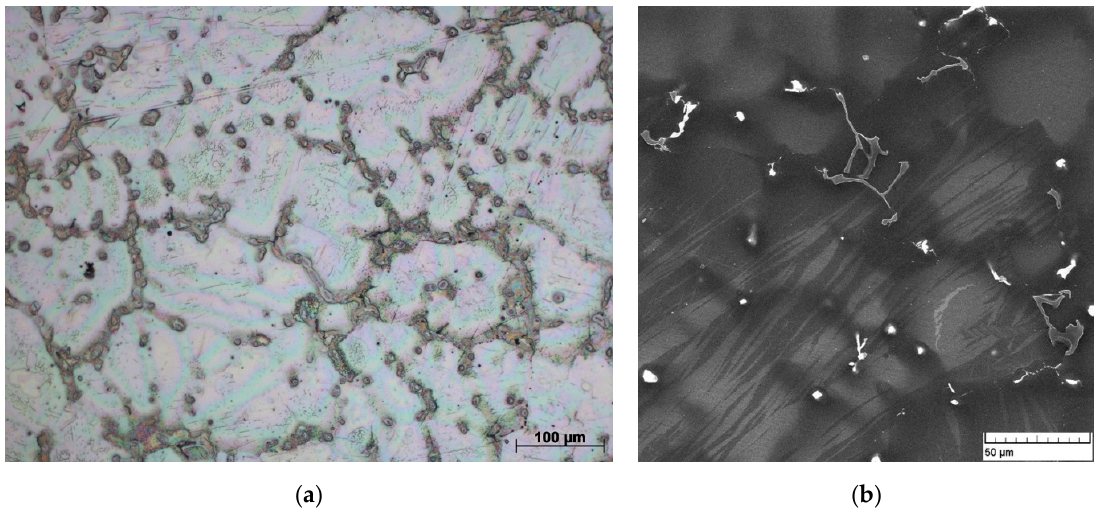
Figure 1. Microstructure of the AZ31 alloy in the initial state. ( a ) Light micrograph. ( b ) Electron micrograph. Picric acid was used for etching.